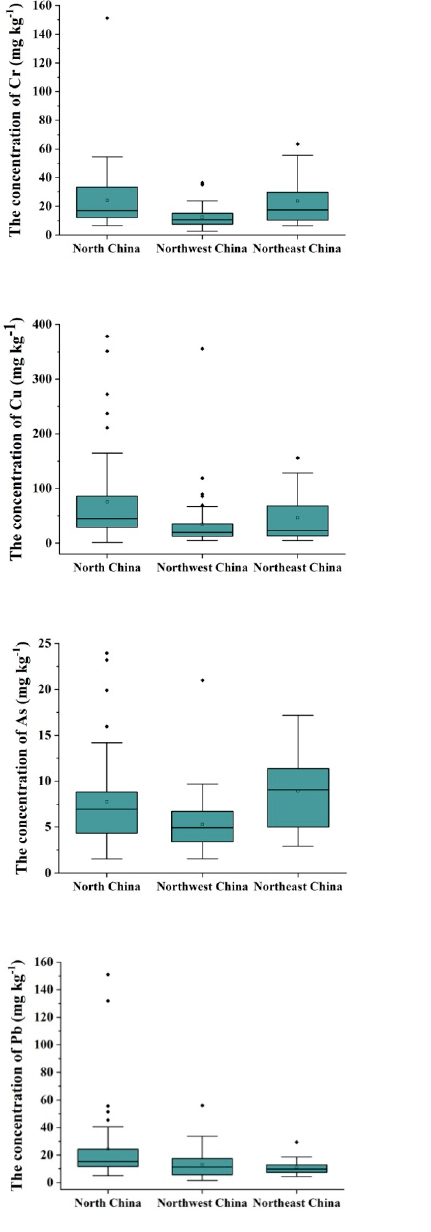
Figure 2. Trace metal concentrations of organic fertilizers in North China ( n = 48), Northwest China ( n = 55), and Northeast China ( n = 14). Squares represent mean values, the band near the middle of each box represents the median, and the bottom and top of the boxes represent the lower quartile (LQ; 25th percentiles) and upper quartile (UQ; 75th percentiles), respectively. The vertical lines (whiskers) represent the 1.5 inter-quartile ranges (IQRs) of the lower and upper quartiles. Data outside the whiskers are outliers and are plotted as dots.